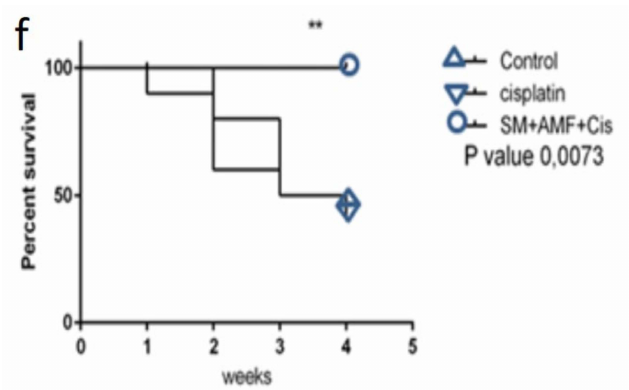
Figure 4. Targeting studies in vivo. ( a ) Schematic drawing of the experimental setup used in AMF experiments for treatment of oral squamous cell carcinoma (SCC). The top of the coil is placed near the tumor, and the tumor is exposed to AMF treatment. ( b ) Visualization of the ICG imaging marker delivered by SM-liposomes (MESL) with ferric nanoparticles in an orthotopic mouse model of SCC9 oral squamous cell carcinoma. The representative mice were imaged after 6 h of IV injection of ICG that contained MESL. After tail vein injection of MESL, mice were treated with AMF (20 min, 1.5 mT, 100 kHz). ( c ) The control mice received an IV injection of MESL with ICG without AMF treatment. The representative mouse was imaged 6 h after injection. ( d ) Longitudinal comparison of tumor uptakes of ICG delivered by MESL delivery system treated with ( • ) or without ( (cid:4) ) AMF treatment. Quantification of relative fluorescent signal (RFI) from ICG signal in SCC-9 human xenograft bearing nude mice was imaged by Night OWL imaging system. The study was conducted after the injection of ICG and iron nanoparticles containing SM-liposomes. Immediately after injection of liposomes, the tumor region was treated with 1.5 mT AMF (20 min) vs. the control group that was not subject to AMF. Each bar represents the mean ± SEM. ( e ) Longitudinal comparison of in vivo tumors to background fluorescence ratio of ICG containing MESL with AMF treatment ( (cid:4) ) or the same liposomes without AMF treatment ( (cid:78) ). Tumor signals were derived from the SCC tumor, and the muscle tissue from the front leg was used as the background tissue. ( t -test p -value 0.0029). ( f ) Kaplan–Meier presentation of the survival study of SCC-9 tumor-bearing orthotopic xenograft mice. Mice were treated with IV injections of ICG, cisplatin ( ∆ ) (120 µ L 0.65 mg / mL equivalent to 12 mg / m 2 ) or liposomal cisplatin formulations ( ◦ ) (120 µ L 0,65 mg / mL equivalent 12 mg / m 2 ) once per week for 4 consecutive weeks. p value 0.0073 treated versus